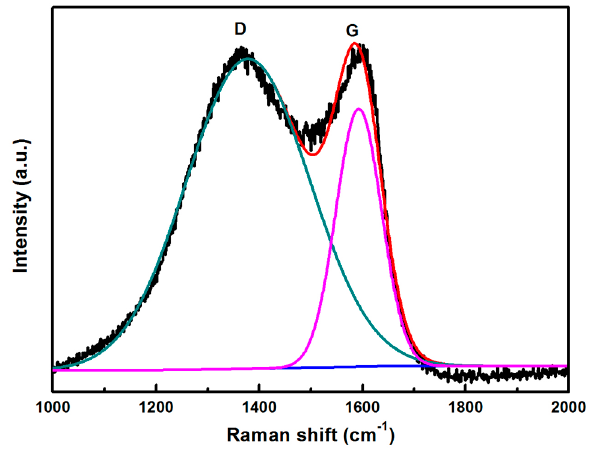
Figure 3. Raman spectra of thin BCN sheets.